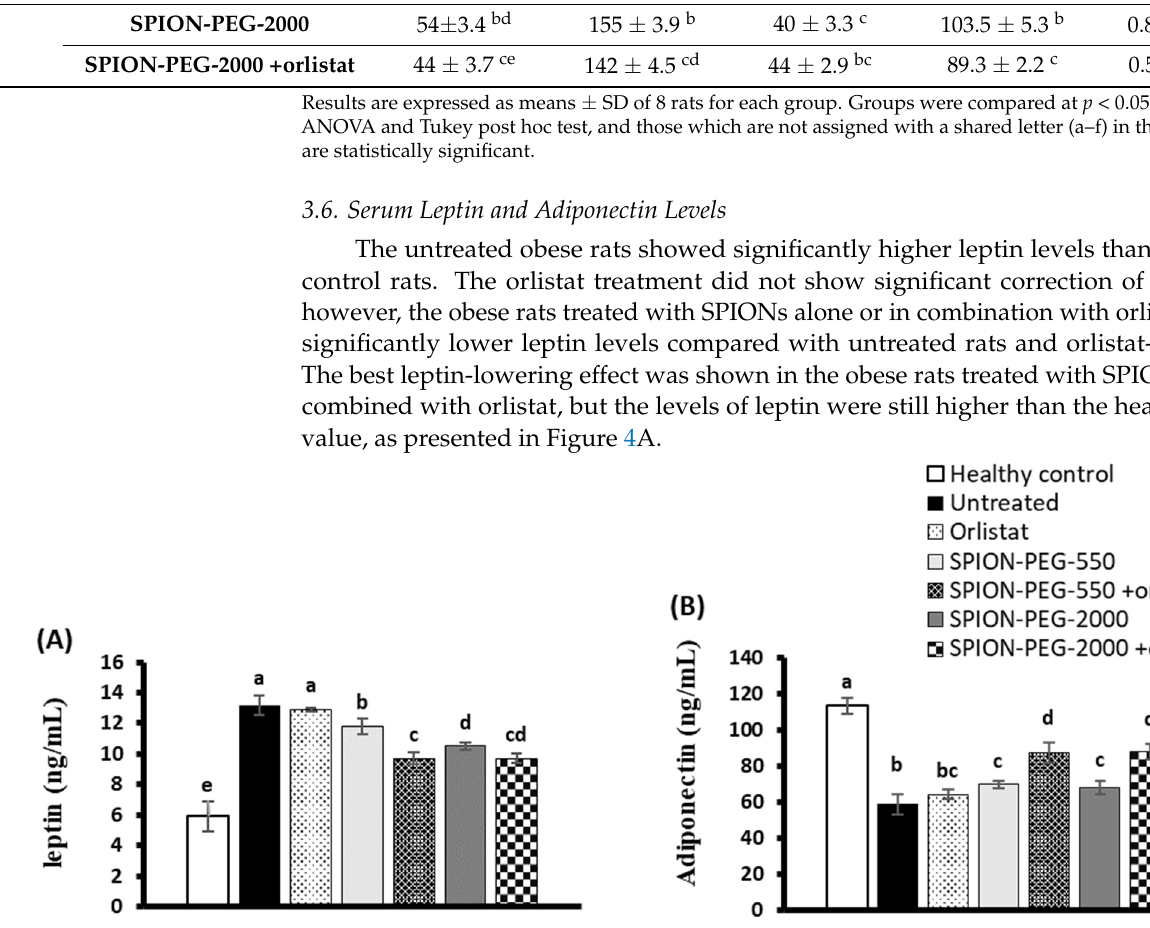
Figure 4. Serum leptin ( A ) and adiponectin ( B ) levels in control rats and obese rats untreated or treated with SPIONs and/or orlistat. Data presented as mean ± SD, and n = 8. Groups were compared at p < 0.05 using one-way ANOVA and Tukey post hoc test, and those which are not assigned with a shared letter (a–e) are statistically significant.